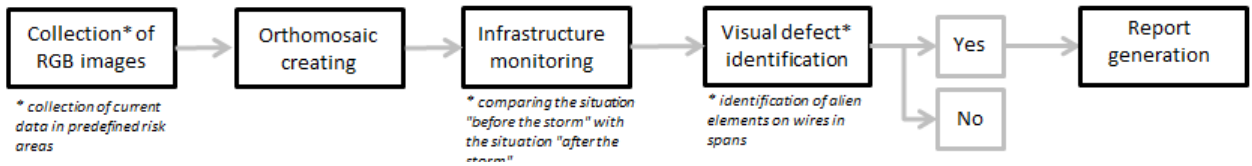
Figure 26. Unplanned network infrastructure inspection workflow.